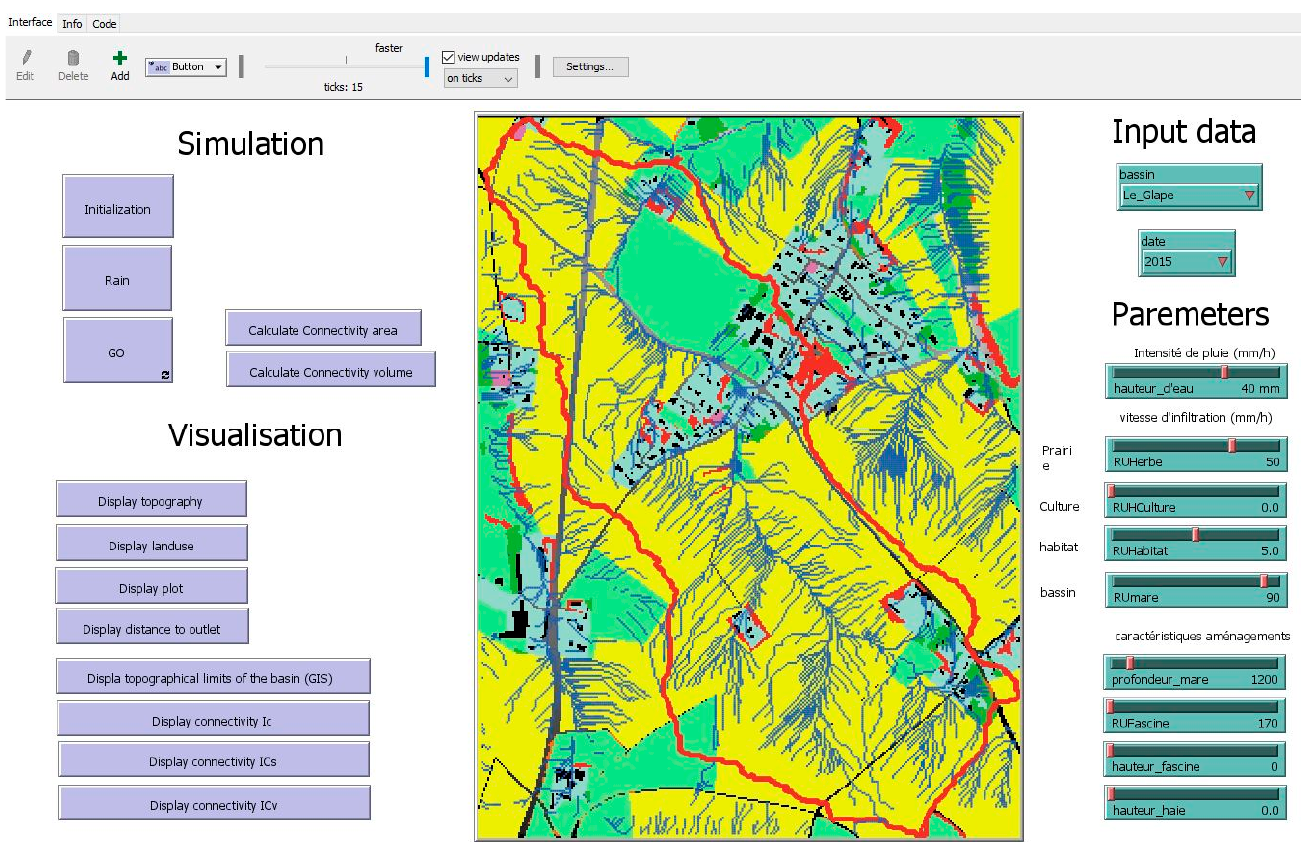
Figure 4. Overview of the software interface.